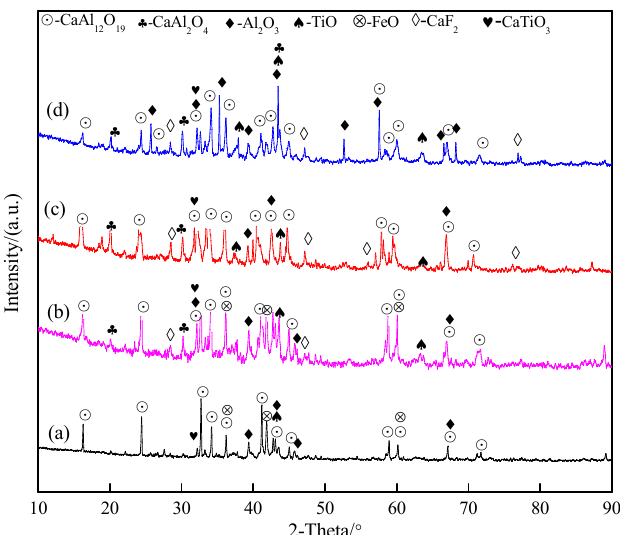
Figure 2. X-ray diffraction patterns of slags formed from ilmenites with different reduction degrees. ( a ) 0%, ( b ) 11%, ( c ) 43%, and ( d ) 75%.